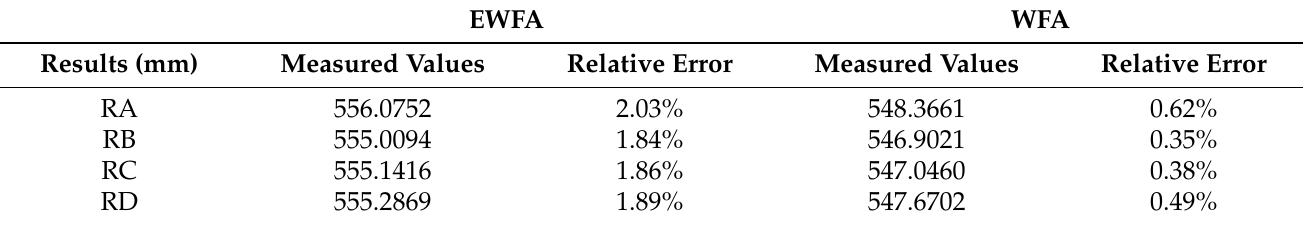
Table 15. The calculated radii of the second experiment.